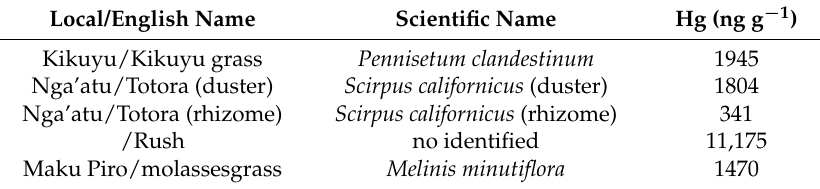
Table 1. Mercury concentrations in vegetation samples collected in Easter